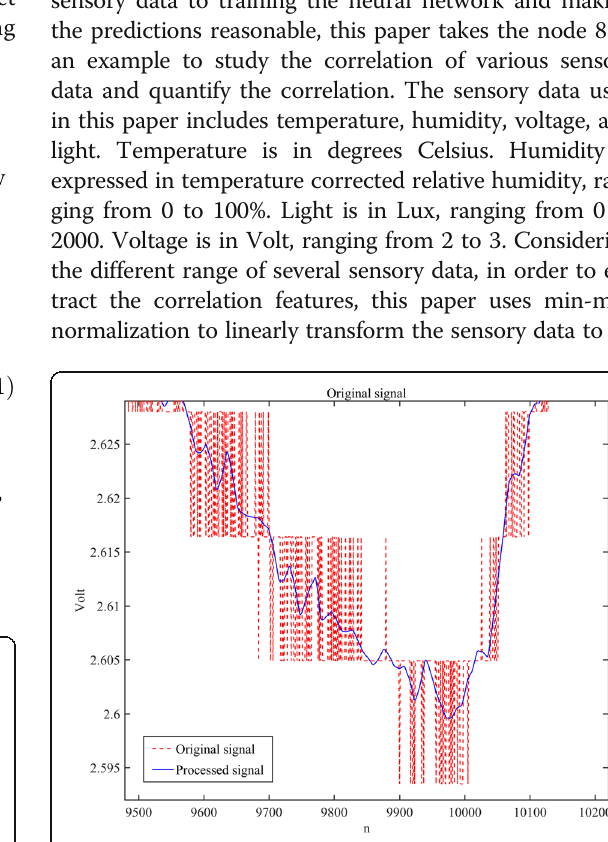
Fig. 6 Wavelet decomposition of cA j Fig. 7 Effect of wavelet denoising on voltage data of node